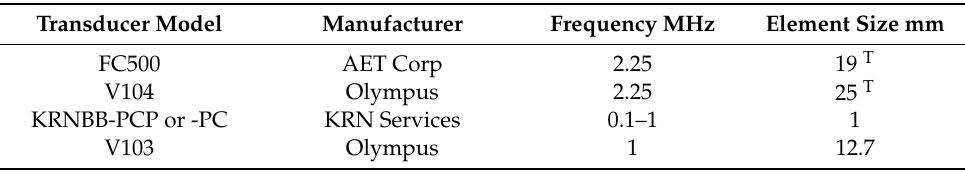
Table 1. Transducers and sensors used.